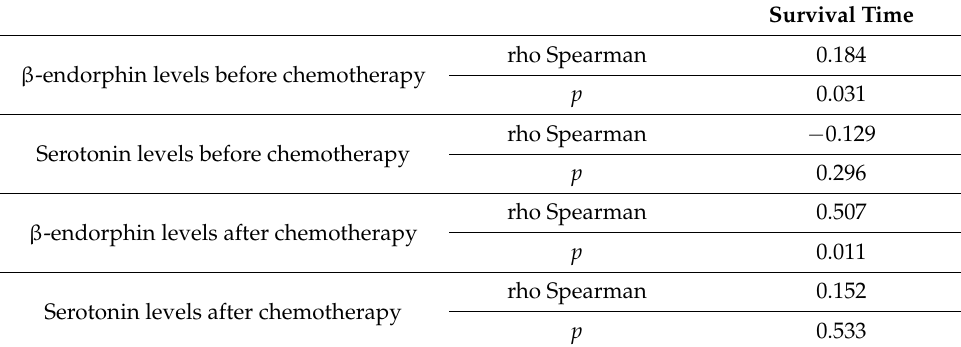
Table 11. Relationship of β -endorphin and serotonin levels and survival time in the study group- with ovarian cancer (III–IV stage according to